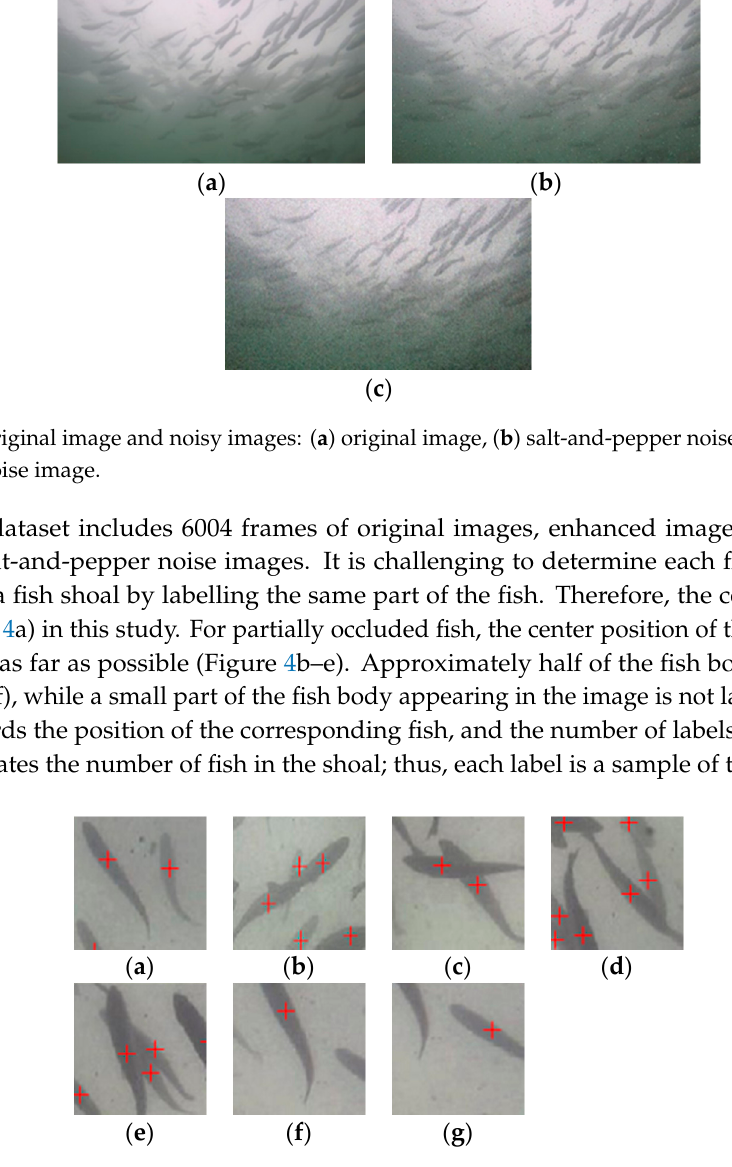
Figure 4. Examples of image annotation. ( a ) no overlap; ( b ) two fish overlap into a line; ( c ) two fish cross like “X”; ( d ) two fish cross like “V”; ( e ) three fish cross; ( f ) about half of the fish body appears; ( g ) a small part of the fish body appears.